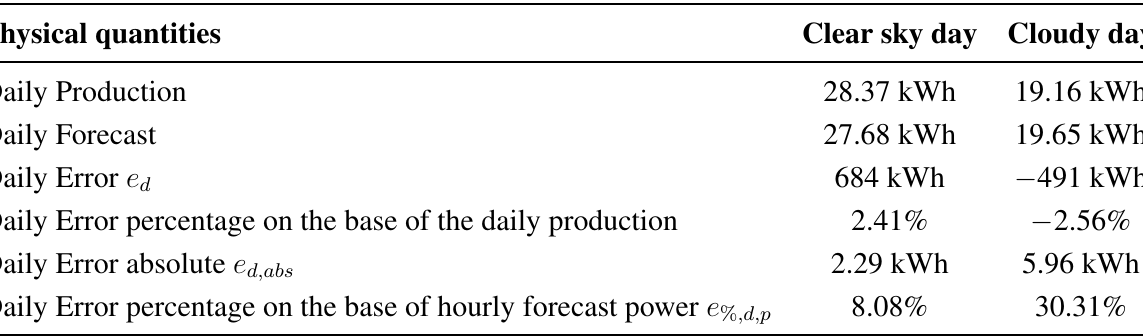
Table 1. Production data and error calculation for two-day examples.